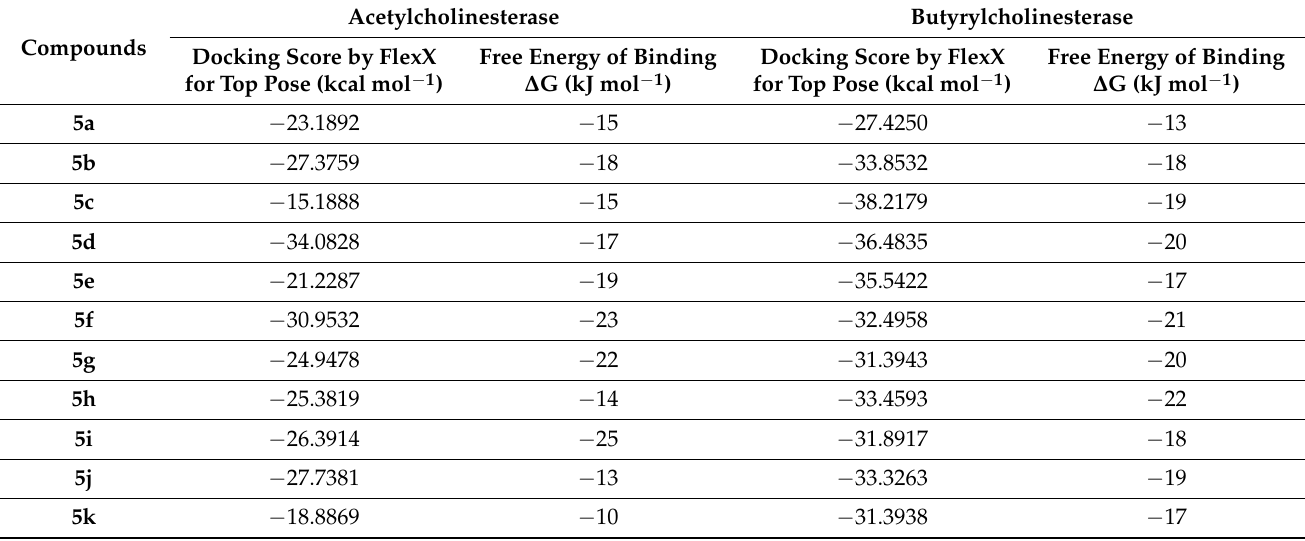
Table 2. Docking score of the top pose of selected compounds and their ranks after HYDE visual inspection in the AChE and